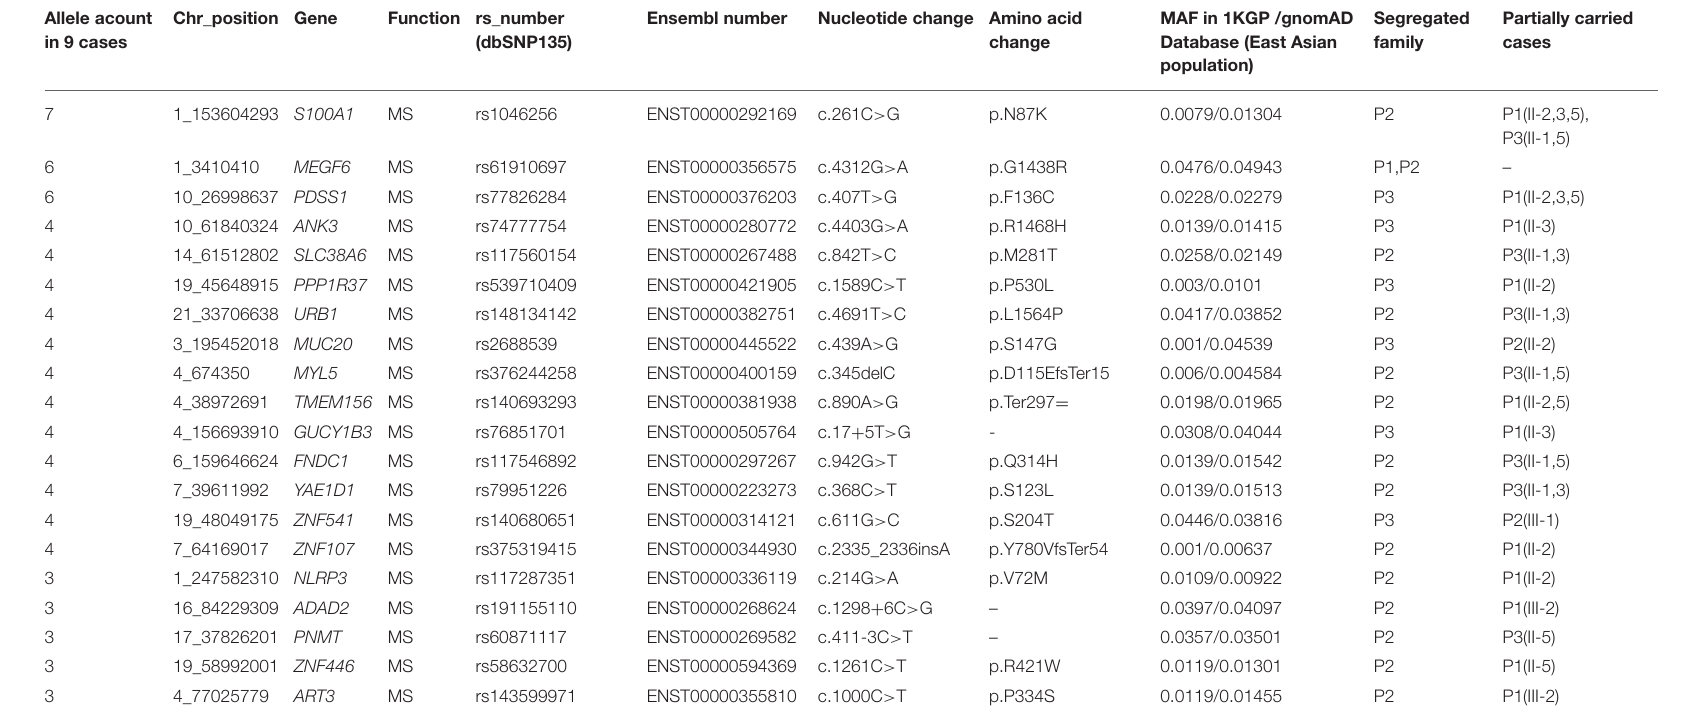
TABLE 3 | Filtered variants shared in familial IA